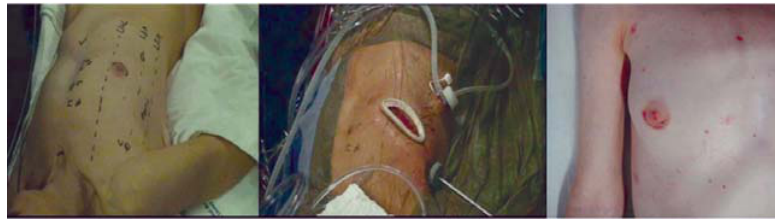
Fig. 2 - Marcações pré-operatórias, aspecto trans-operatório e evolução da cicatriz periareolar em 30